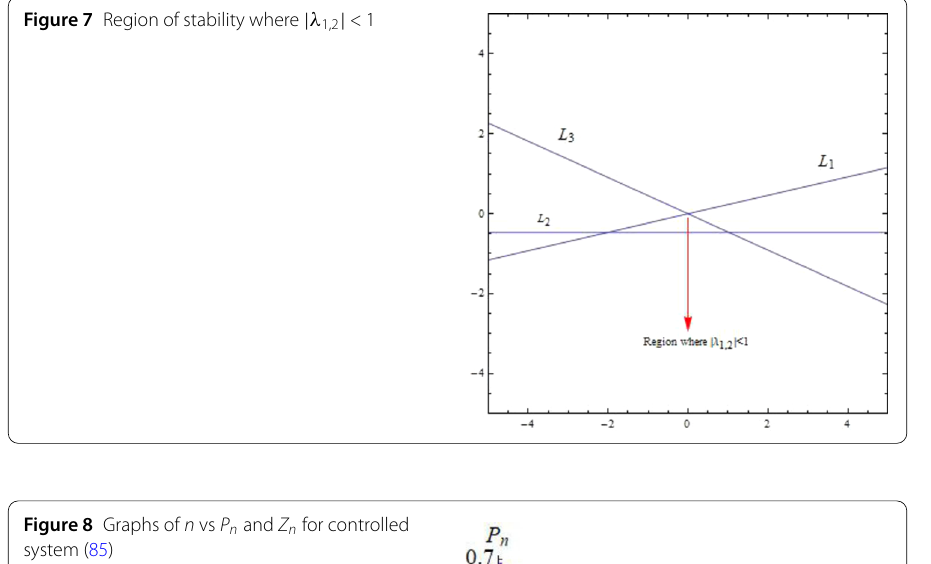
Figure 7 Region of stability where | λ 1,2 | < 1